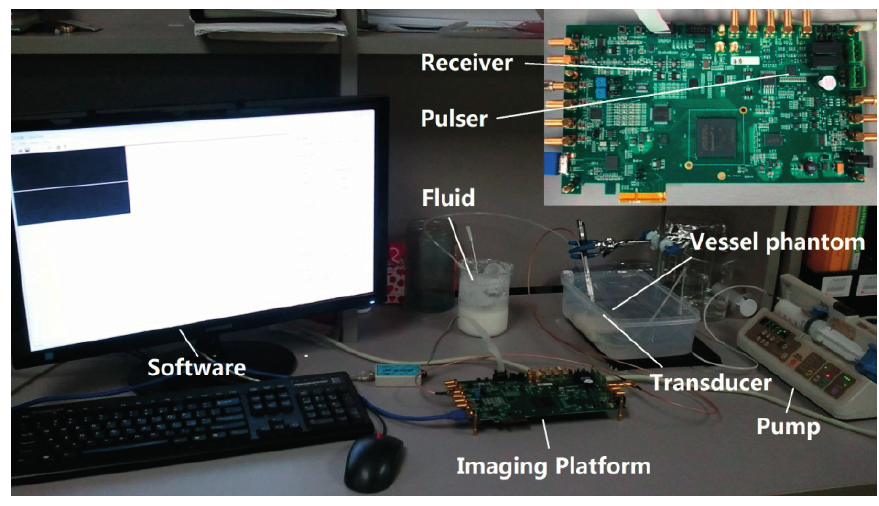
Figure 5. Photograph of integrated imaging platform and experimental setup for multigate PW Doppler